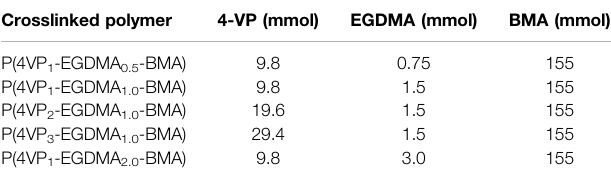
TABLE 3 | Synthetic feed of monomers used to synthesize crosslinked polymers. Crosslinked